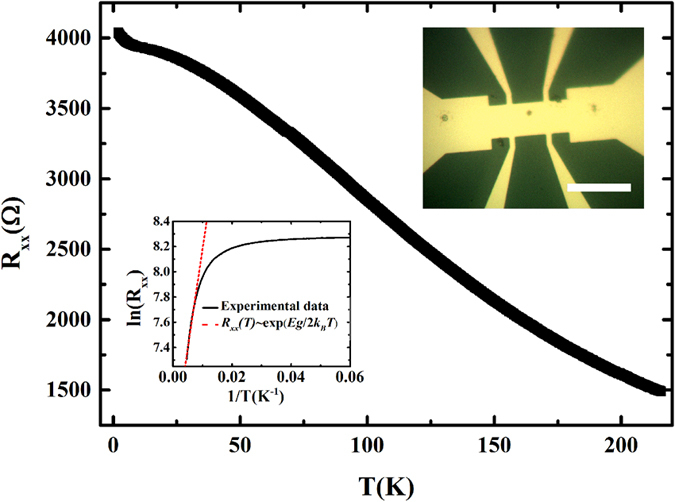
Temperature dependence of the resistance of the Cd3As2 film device CA2.The right inset shows its optical image with the scale bar of 50 μm. The left inset shows the Arrhenius fitting of with the result of a 21.9 meV band gap.